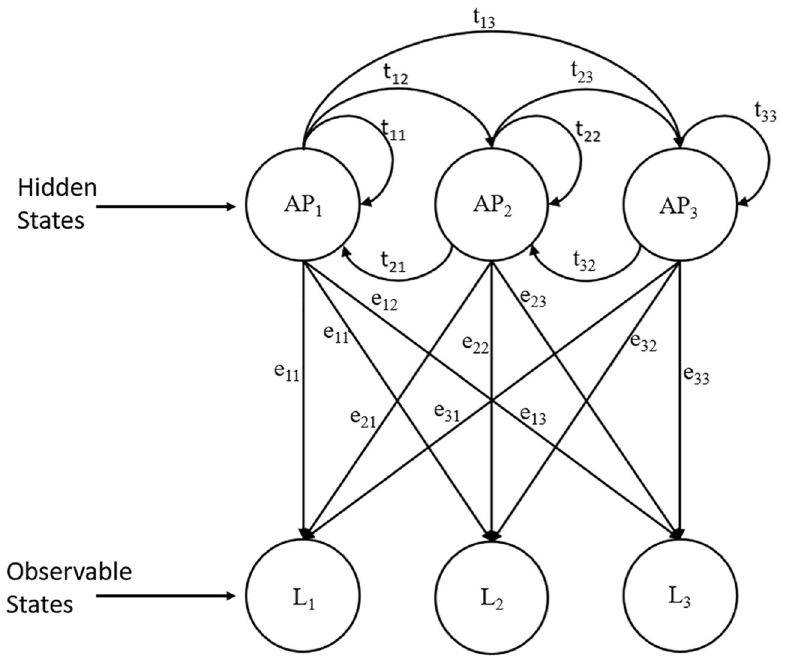
Fig 13. Second HMM represented by location and WiFi